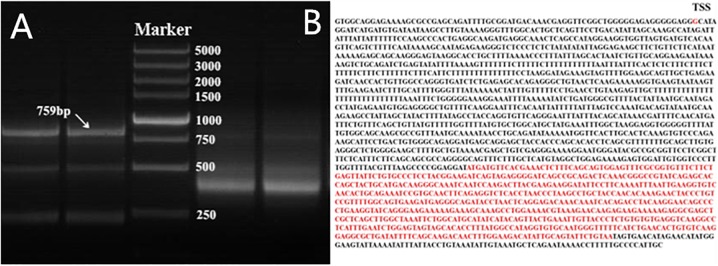
Nested PCR results of 5′- and 3′-RACE of chicken PTHLH gene. (A) 5′- and 3′-RACE products were separated by 1% agarose gel electrophoresis. 3′-RACE product is on the left of Marker, and 5′-RACE product is on the right of Marker. DL 5,000 DNA Marker (TaKaRa, Dalian, China) consisted of eight fragments between 250 and 5,000 bp. (B) The mRNA sequence of PTHLH transcript variant X1, the transcription start site (TSS) was G, and the CDS has been marked with red color.